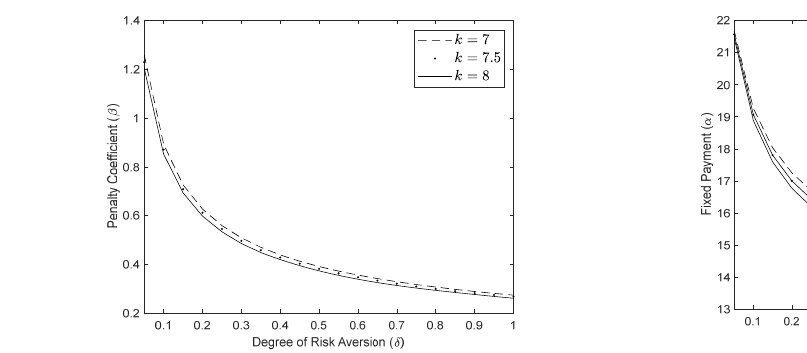
Fig. 2. The effect of degree of risk aversion on the penalty coefficient